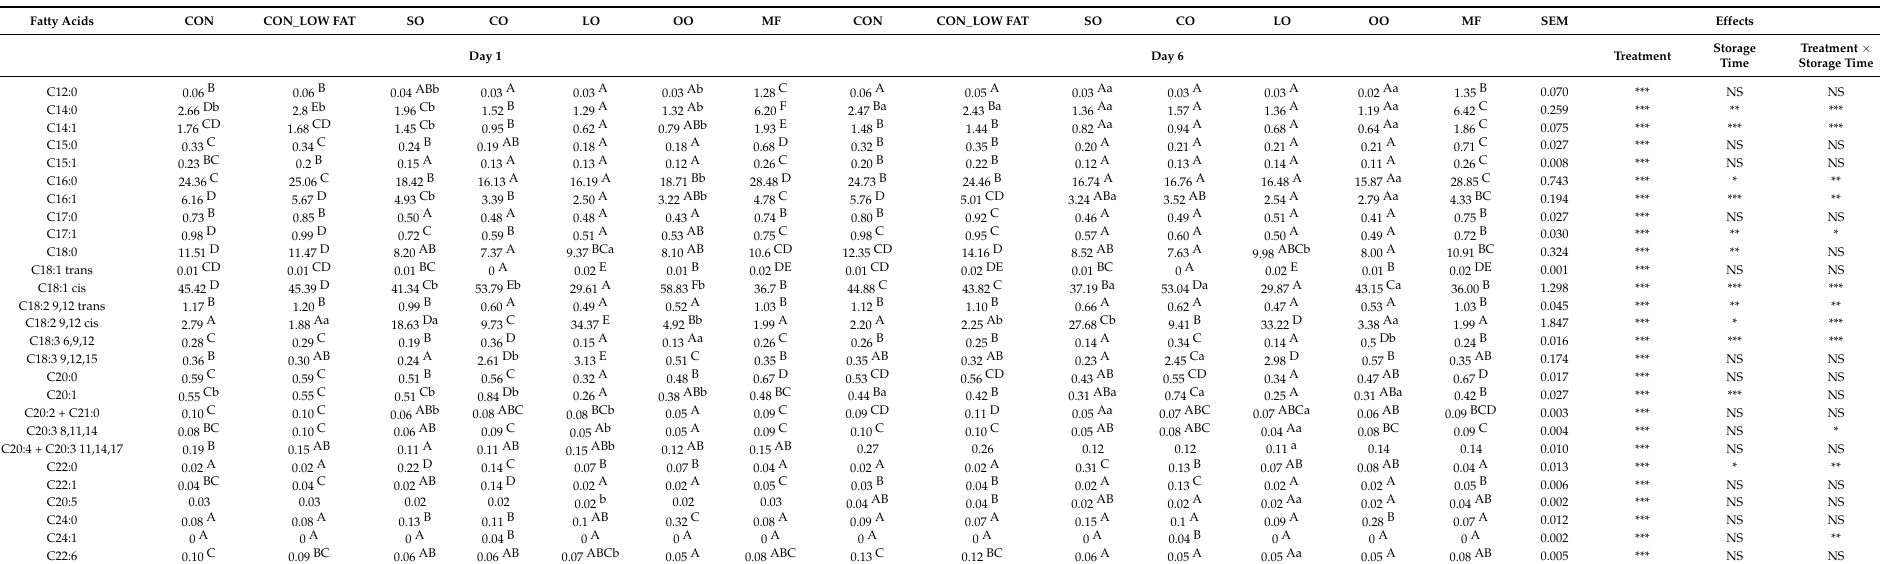
Table 5. Fatty acid profile of raw burgers on day 1 and day 6 of storage (mean ± SE).